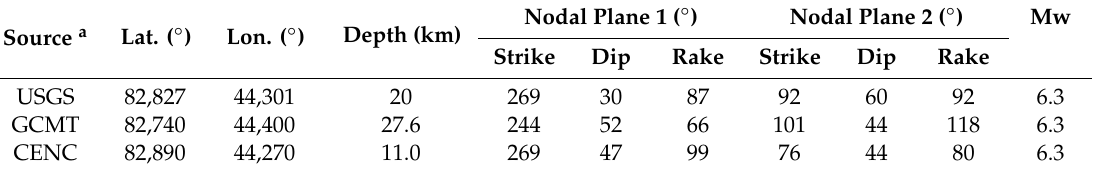
Table 1. Focal mechanism solutions of the 2017 Mw 6.3 Jinghe